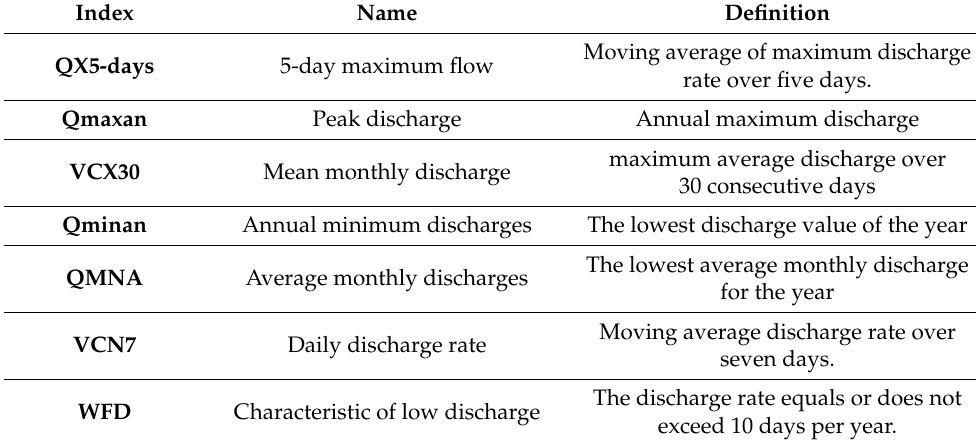
Table 2. Extreme discharge indices (m 3